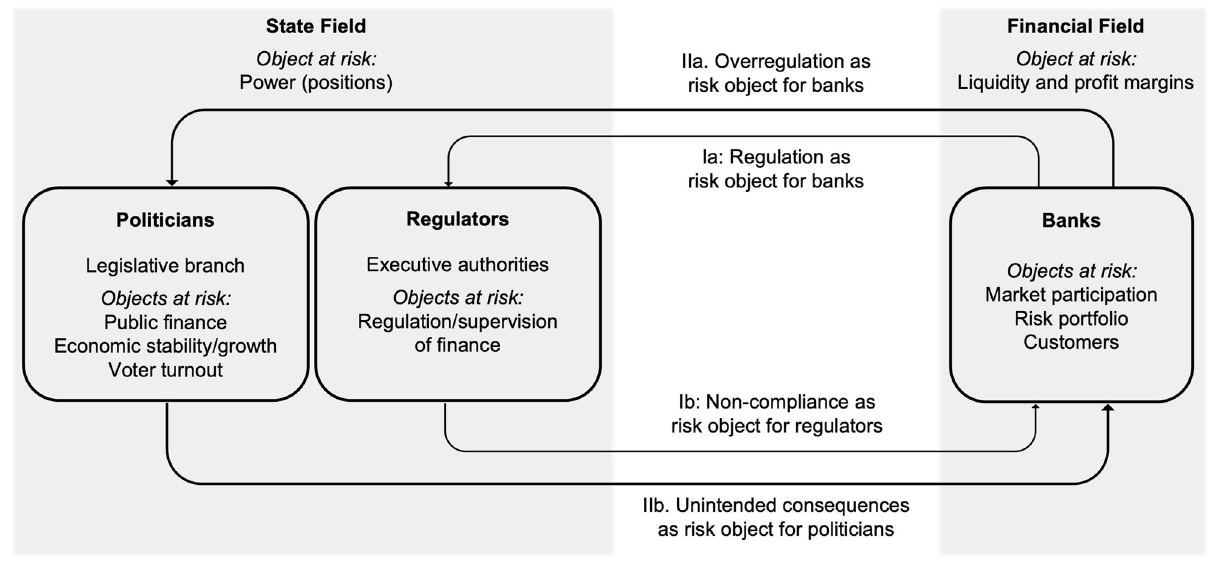
Fig. 1 Risk entanglement in the fi nance-state nexus. Arrows point from actors who construct towards those who are constructed as risk